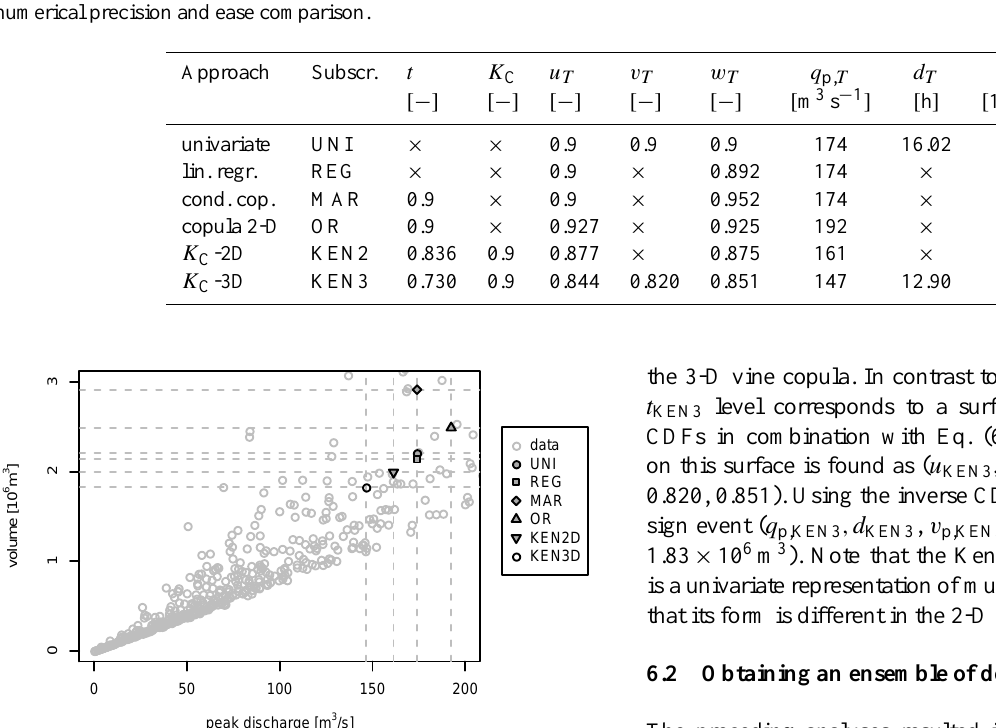
Table 3. Overview of the calculated design event for T =10yr, based on several approaches. The values are rounded to address the limited numerical precision and ease comparison.